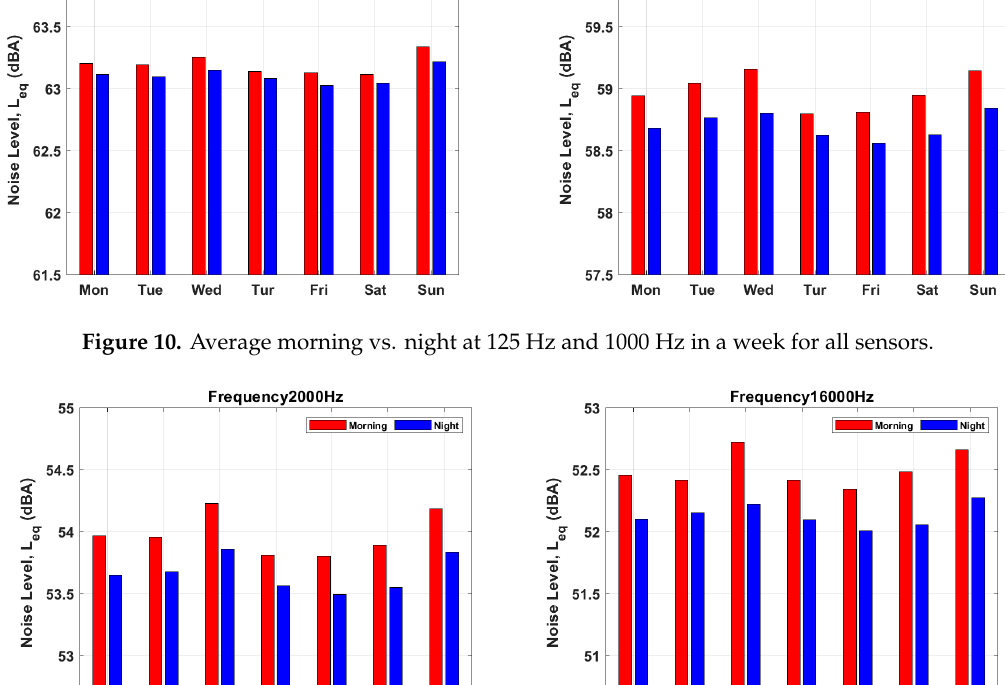
Figure 11. Average morning vs. night at 2000 Hz, 16000 Hz in a week for all sensors.